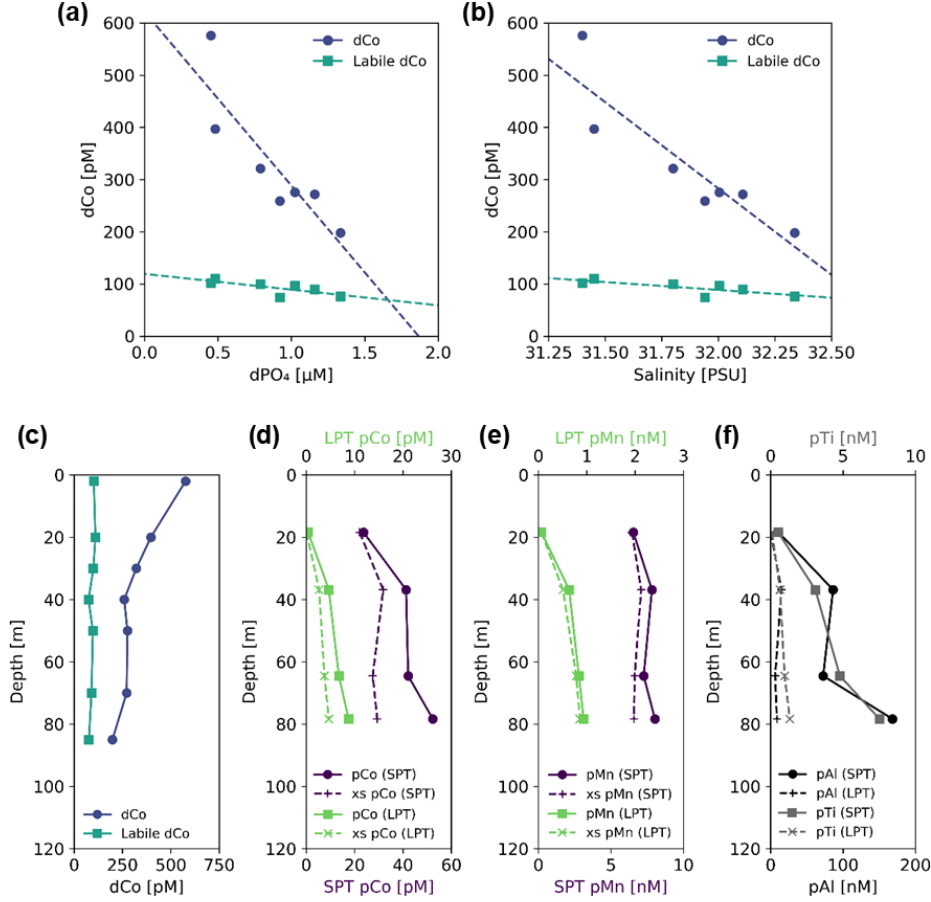
Figure 10. Sample data and profiles from Station 1, a coastal station in the Gulf of Alaska (56.06 ◦ N, 156.96 ◦ W); (a) dCo and labile dCo vs. dPO 4 show a significant negative correlation (slope =− 430 ± 88, µmol:mol; R 2 = 0.77 and slope =− 53 ± 18, µmol:mol; R 2 = 0.57, respectively); (b) dCo and labile dCo vs. salinity show a significant negative correlation (slope =− 406 ± 73pM PSU − 1 , R 2 = 0.81 and slope =− 50 ± 15pM PSU − 1 , R 2 = 0.60, respectively). Depth profiles of (c) dCo and labile dCo and of small particulate, total (SPT) and large particulate, total (LPT); (d) pCo and excess pCo ( xs pCo); (e) pMn and excess pMn ( xs pMn); and (f) pAl and pTi. Note the change in scale of the x axis between SPT and LPT (d, e) and between pAl and pTi (f)